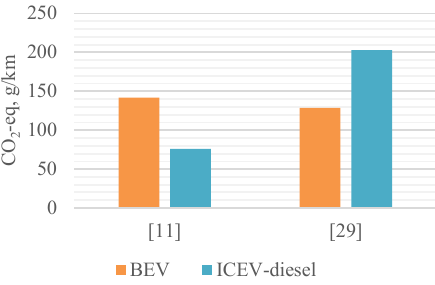
Fig. 4. LCA results relating to the impact of greenhouse gas emissions for studies [11] and [29], respectively in the years 2015 and 2017, for the entire life cycle of